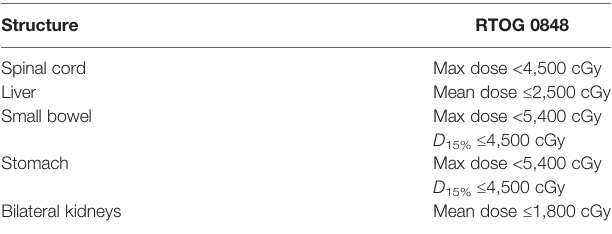
TABLE 1 | Normal tissue dose constraints.